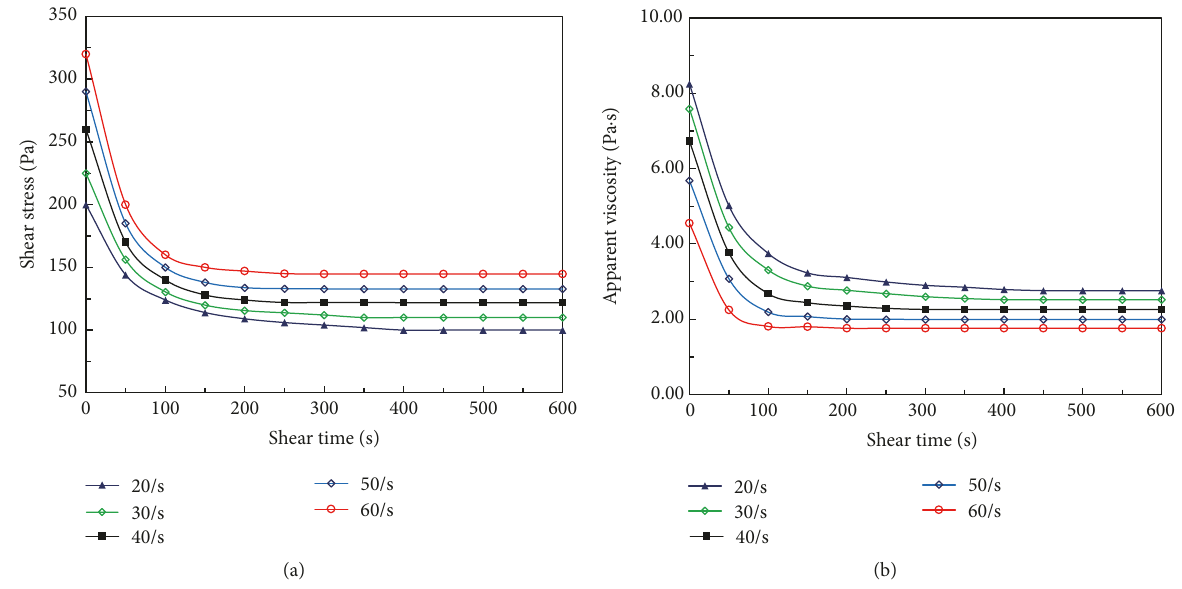
Figure 4: Varying tendency of rheological parameters with shear time: (a) shear stress; (b) apparent viscosity.